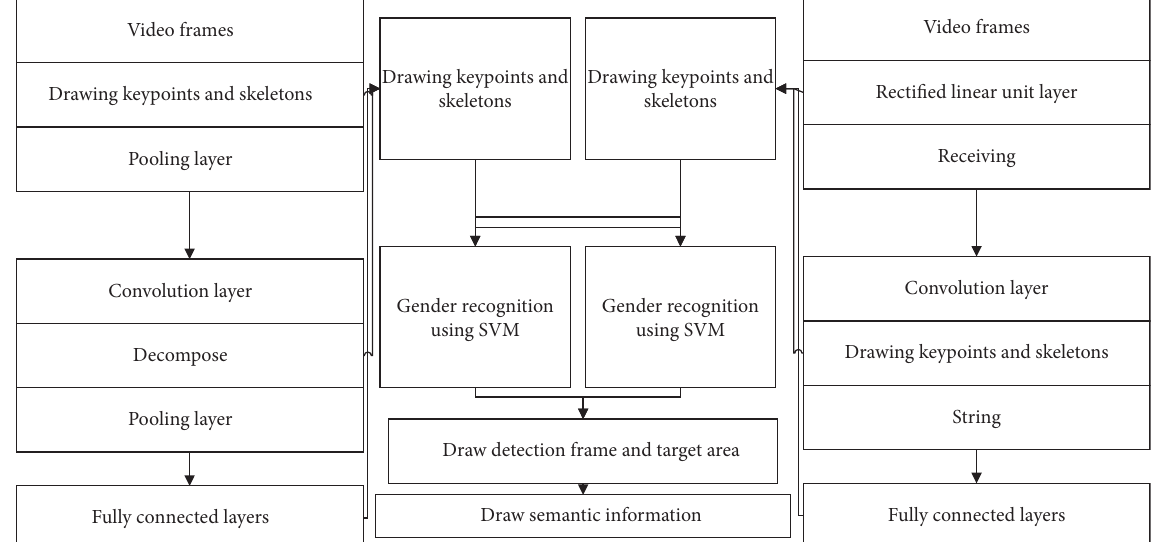
Figure 4: Flowchart of video and semantic display